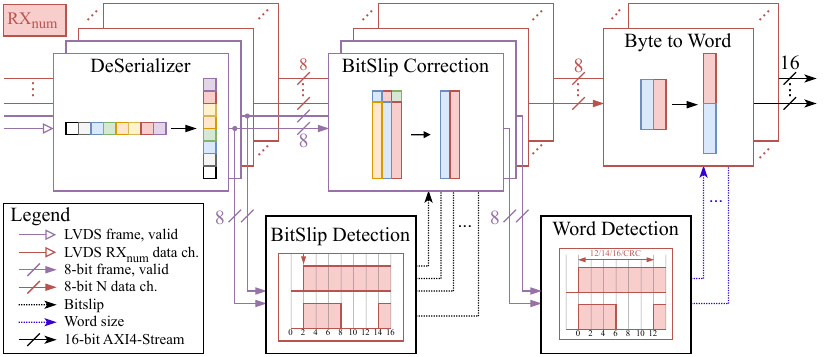
Figure 6. Block diagram of the deserialization and word alignment block. The number of data channels RX num can be